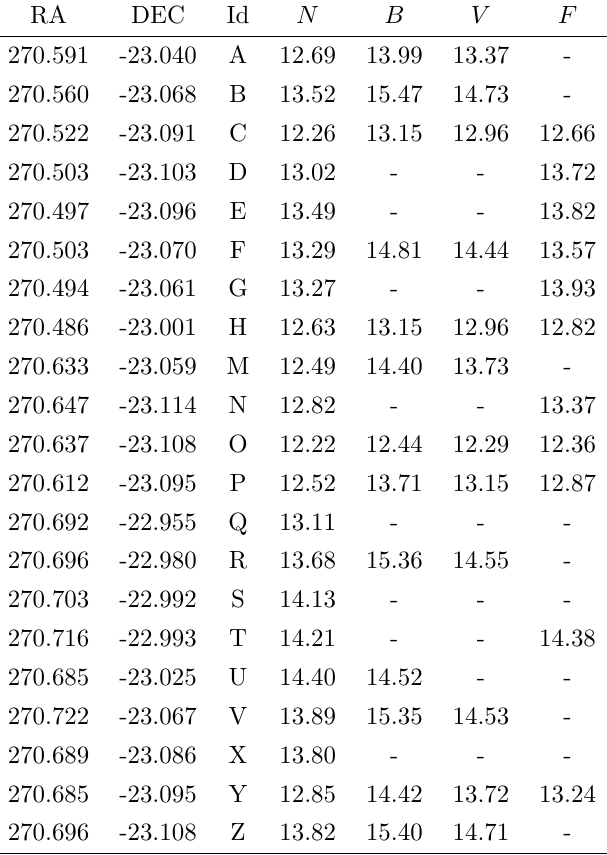
Table 1: Adopted comparison stars sequence